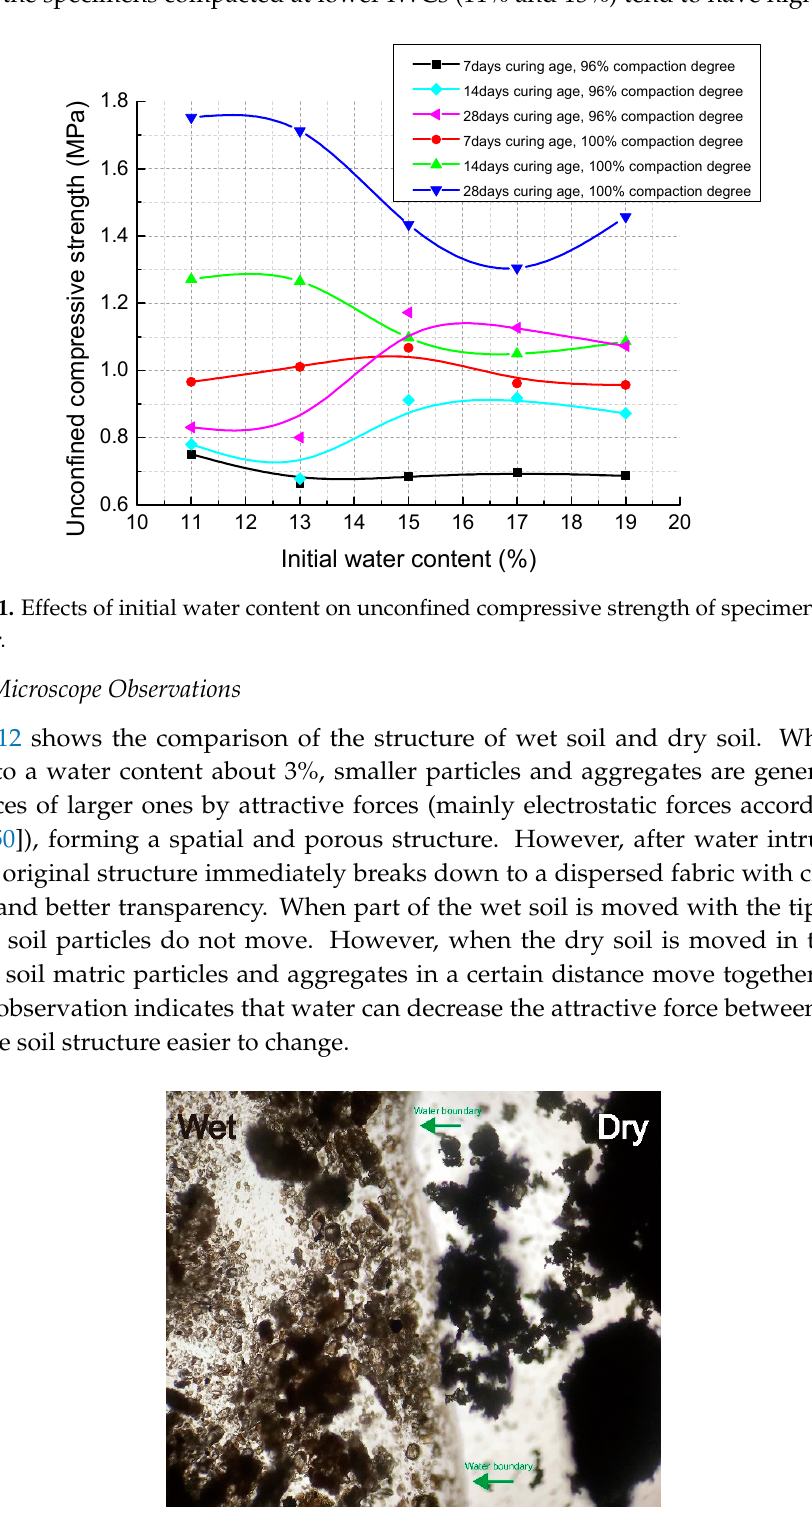
Figure 12. Structure of wet soil ( left ) and dry soil ( right ).